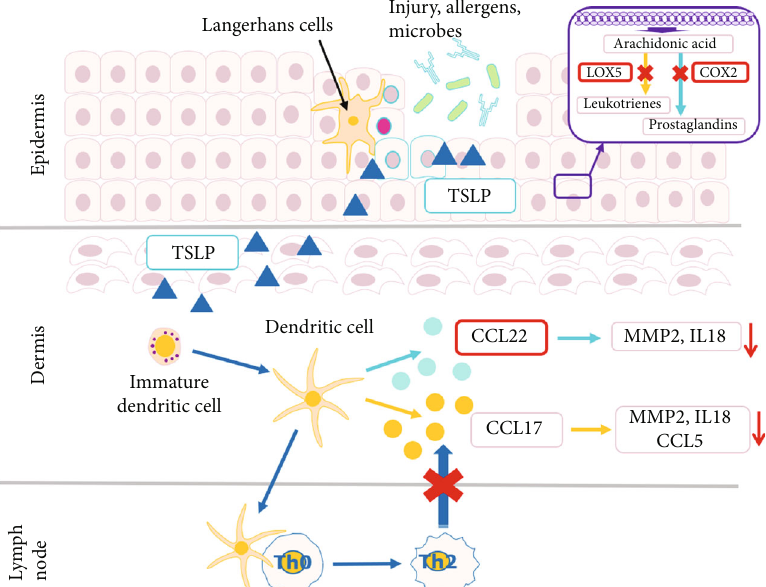
Figure 11: Mode of action of the corn fl ower extract (in red). The biological activities of N -feruloylserotonin are highlighted in red